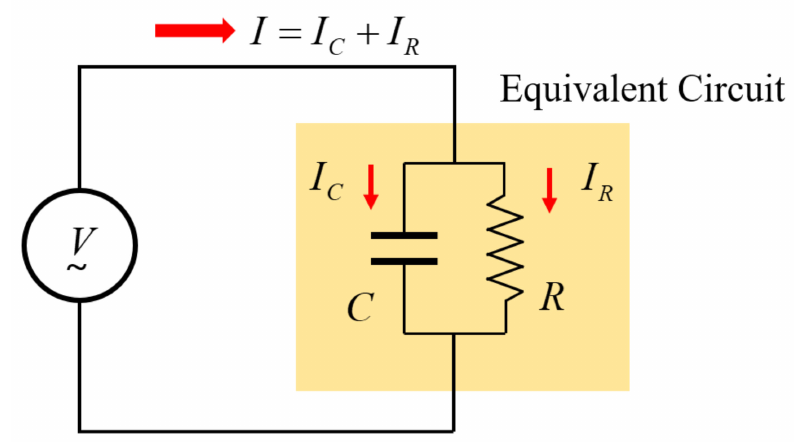
Figure 3. The equivalent circuit represented to RC parallel connection. The impedance of the RC parallel circuit can be expressed as Equation